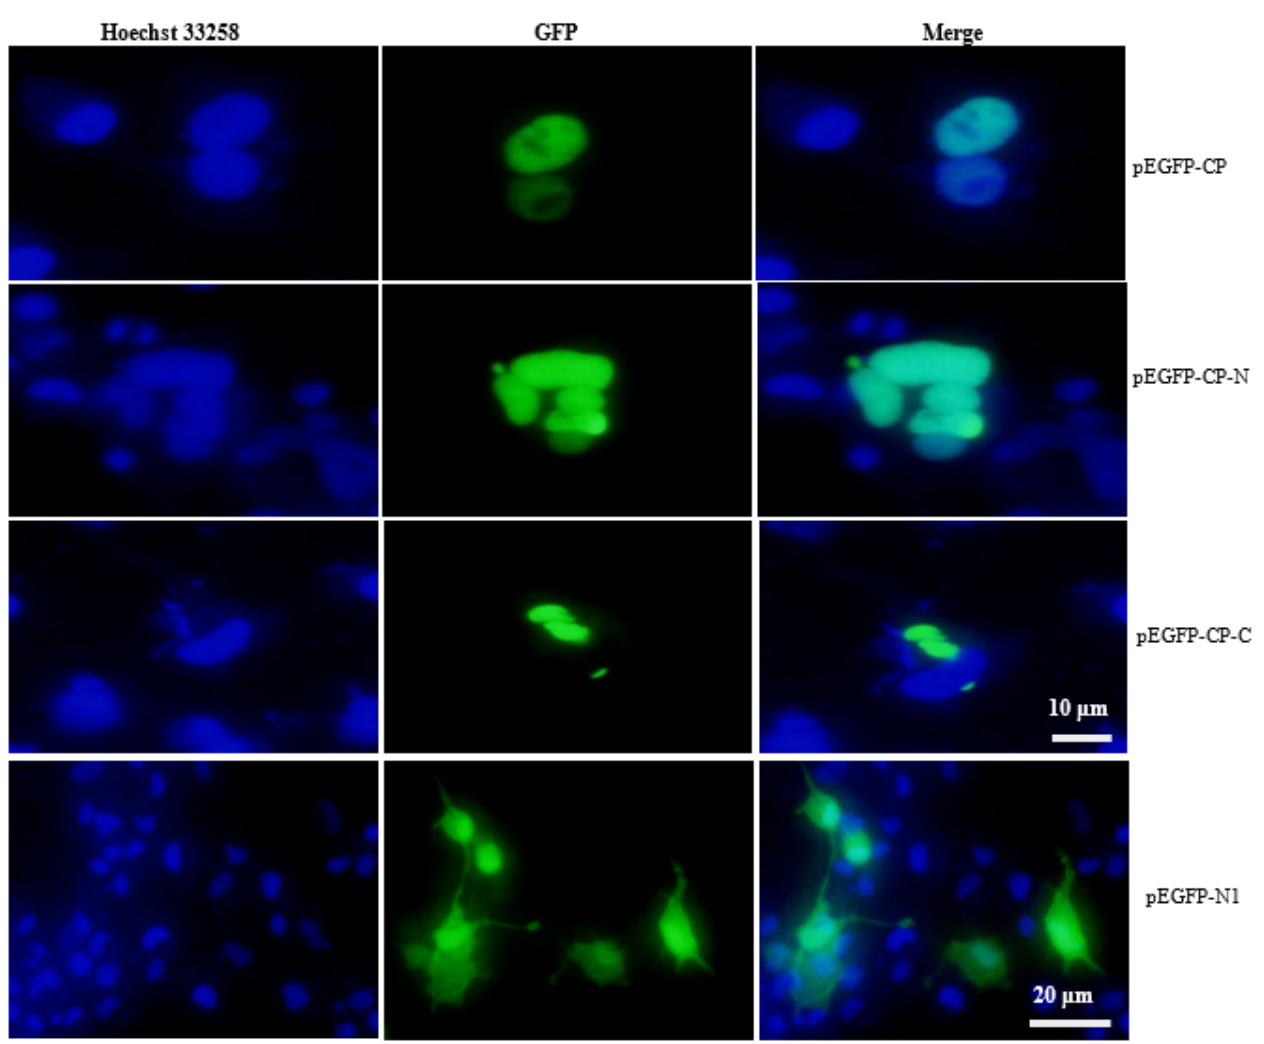
Figure 2. Subcellular localization of NNV-CP in EPC. Subcellular localization of CP in EPC cells transfected with pEGFP-CP-N, pEGFP-CP-C and pEGFP-CP. After allowing the cells to adhere for 48 h in 6-well plates, the nucleus was stained with Hoechst 33258, and fluorescent signals were observed under a fluorescence microscope.